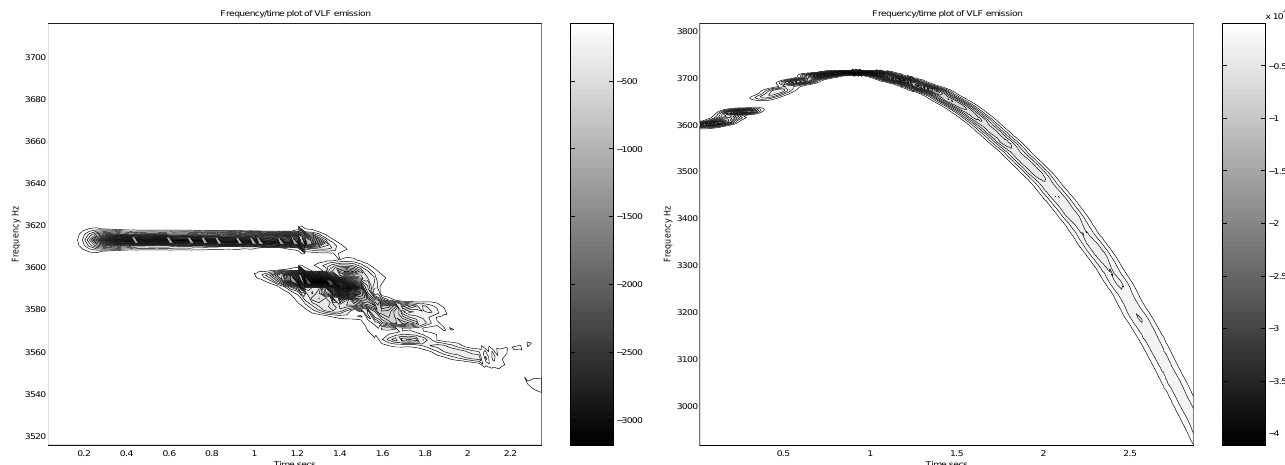
Fig. 6. Strong stable faller produced with a linear growth rate of 90dB/s. The spectral form is actually a downward or falling hook with an offset frequency of +20Hz.